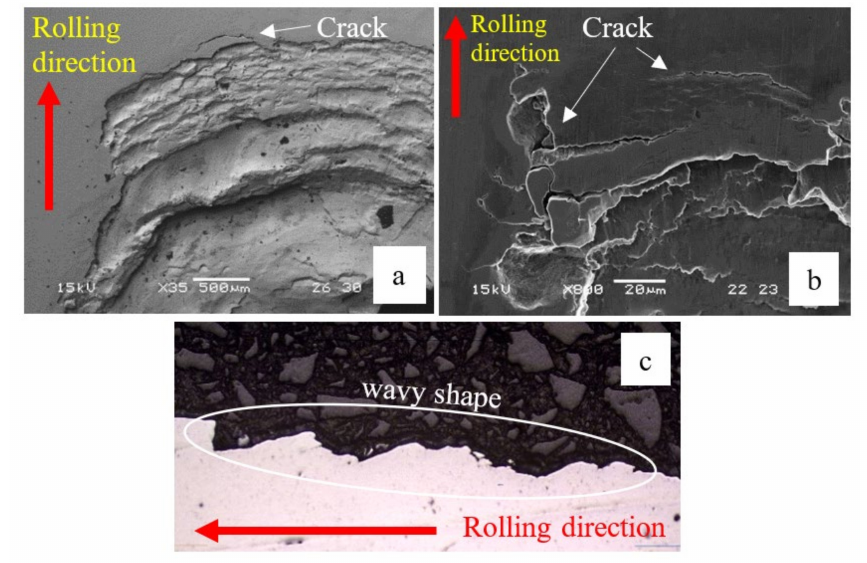
Figure 12. ( a , b ) SEM images of the trailing edge of the spall from the endurance tests. Cracks appeared in front of the spall, which eventually cause the spall to propagate. ( c ) Cross-section of the spall (parallel to the rolling direction). The spall bottom has a wavy shaped ”inclined steps” pattern.